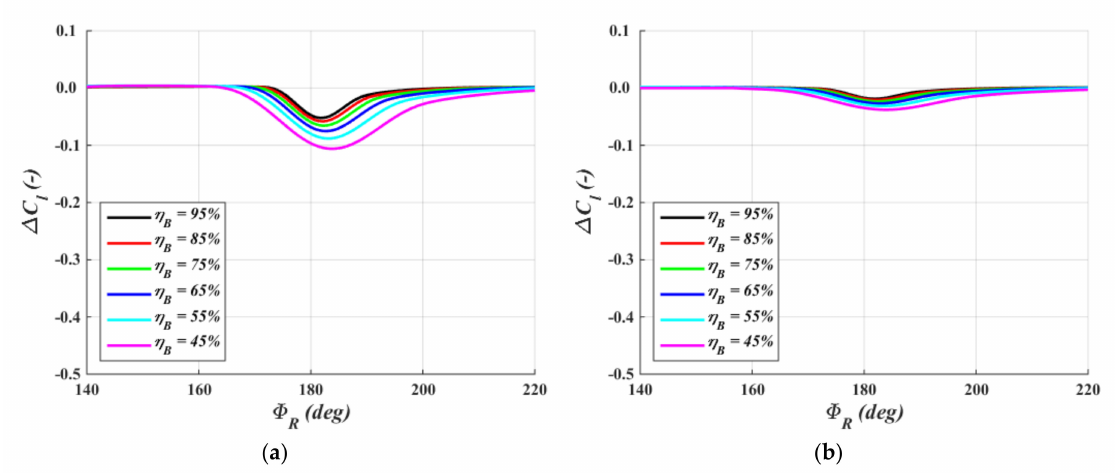
Figure 15. Deviations in lift coe ffi cient of the 1000% model, V T = 36.0 m / s: ( a ) C d = 1.2; ( b ) C d =